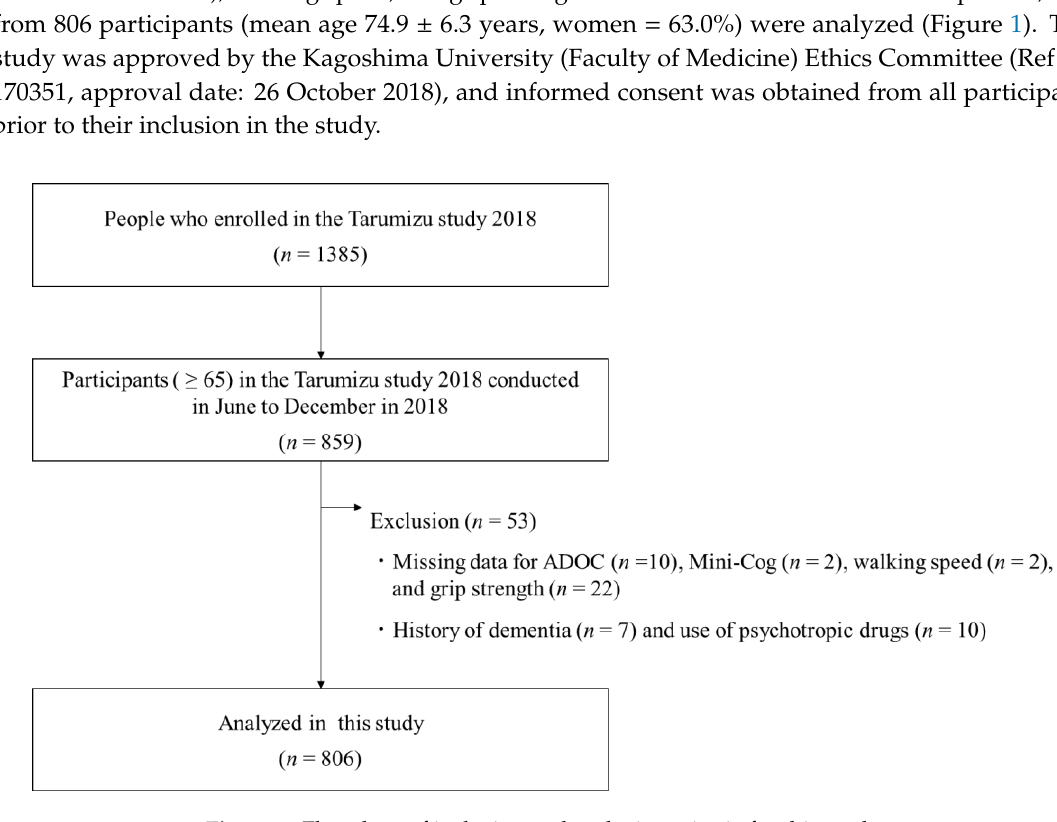
Figure 1. Flowchart of inclusion and exclusion criteria for this study.